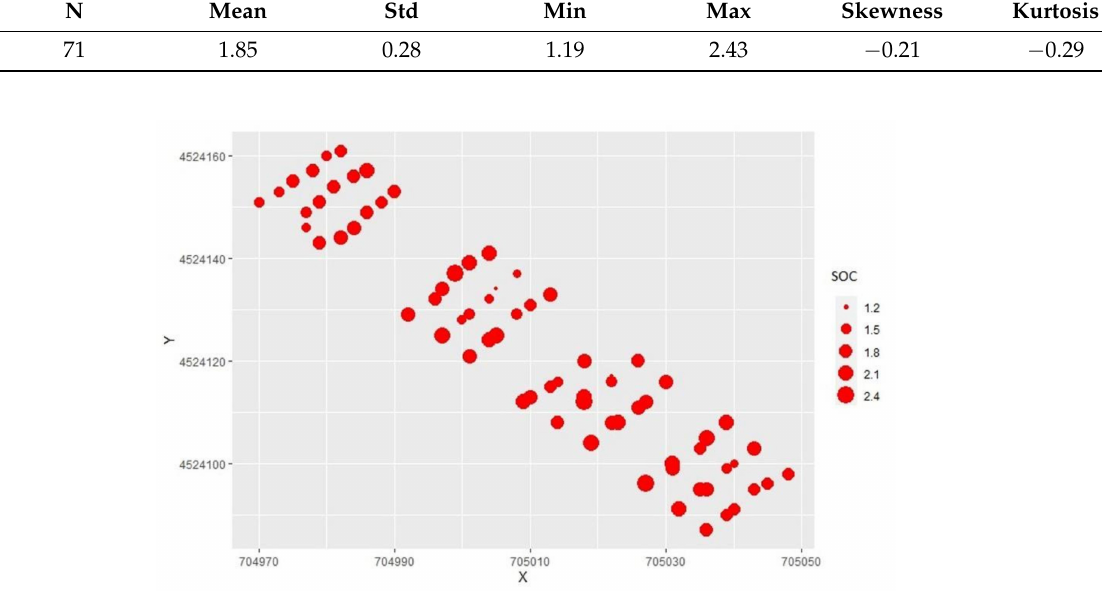
Figure 3. Bubble plot of spatial distribution of SOC values (g 100 g − 1